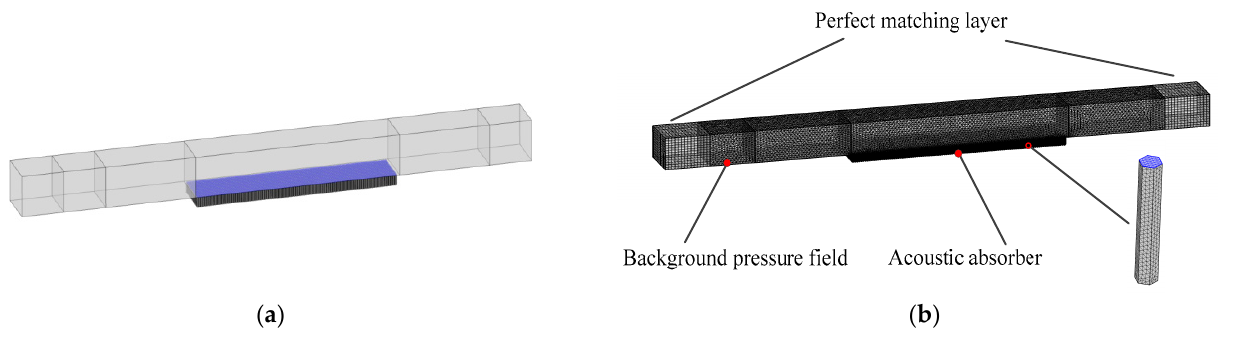
Figure 12. Structure in Reference [15] (suitable for the IBNSE method). ( a ) Geometric model and ( b ) FE model.